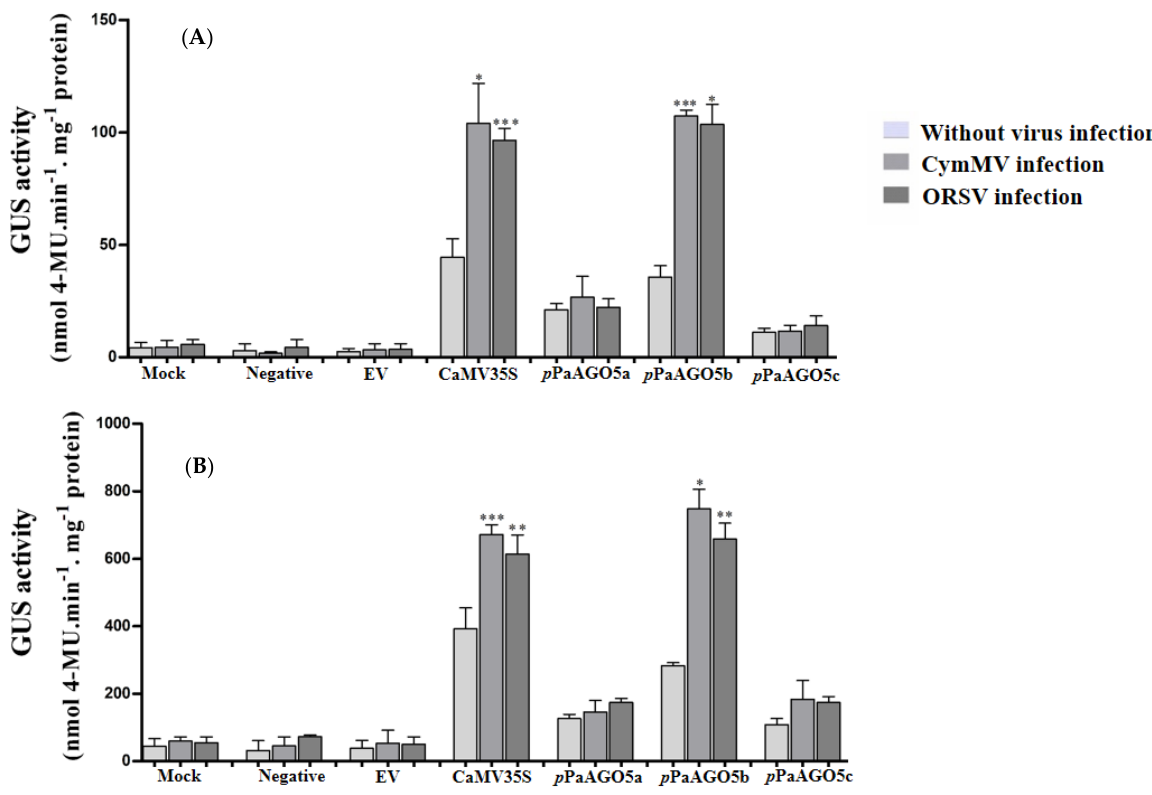
Figure 1. GUS fluorescent quantitative analysis of the p PaAGO5a, p PaAGO5b, and p PaAGO5c. The GUS activity in the wild-type ( A ) P. aphrodite subsp . formosana and ( B ) N. benthamiana leaves during CymMV and ORSV infection at 3 days post-inoculation (dpi). Each promoter GUS construct was assayed at least three times in four independent experiments. The GUS activity, 4-MU nmol-produced min − 1 mg − 1 protein, is represented as the mean ± SD of each mock (infiltration buffer only), negative and empty vector (EV; pKn), CaMV 35S, p PaAGO5a, p PaAGO5b, and p PaAGO5c. Data are mean ± SD, * p < 0.05, ** p < 0.01, *** p < 0.001 by Student’s t -test, respectively.